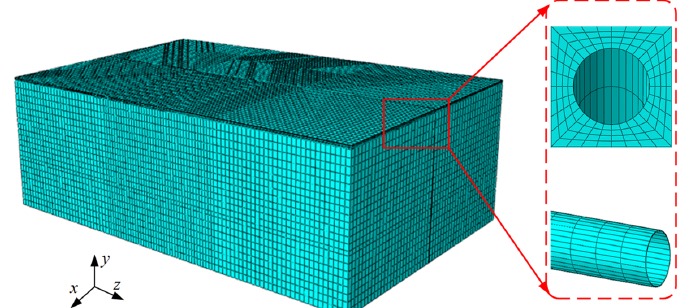
Figure 3. Finite-element model meshing.